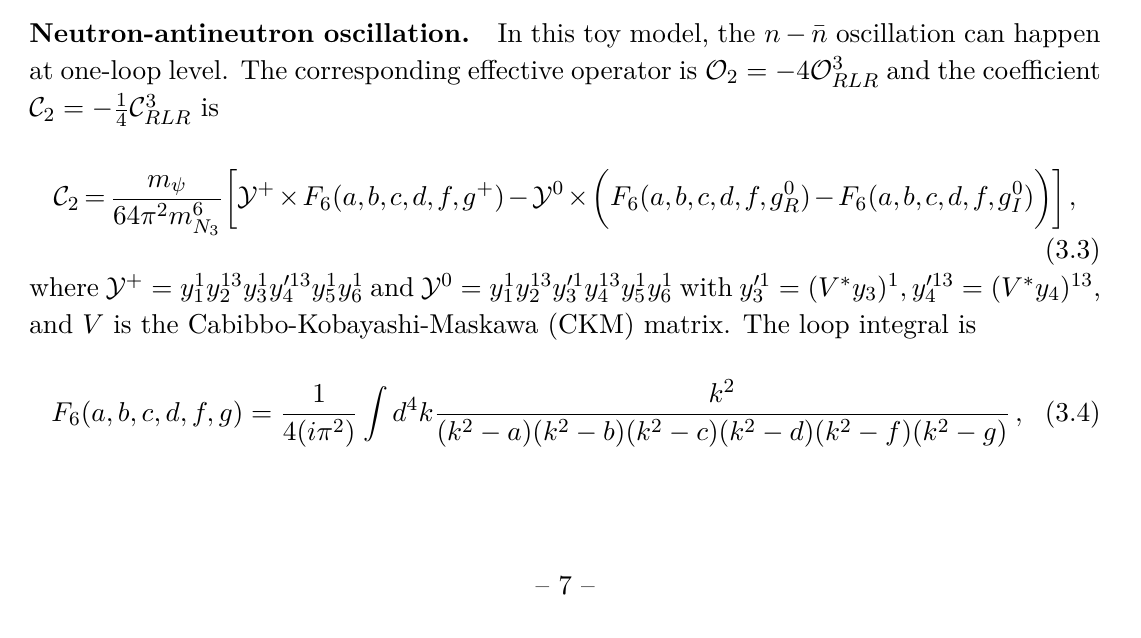
Figure 6 . The correlation between the coefficient | y 1 m ≡ m ψ = m S . The narrow bands show the errors from the nuclear matrix elements. The Super-K i experiment excludes the parameter region above the lines (the region in gray). We have fixed that m N = 2